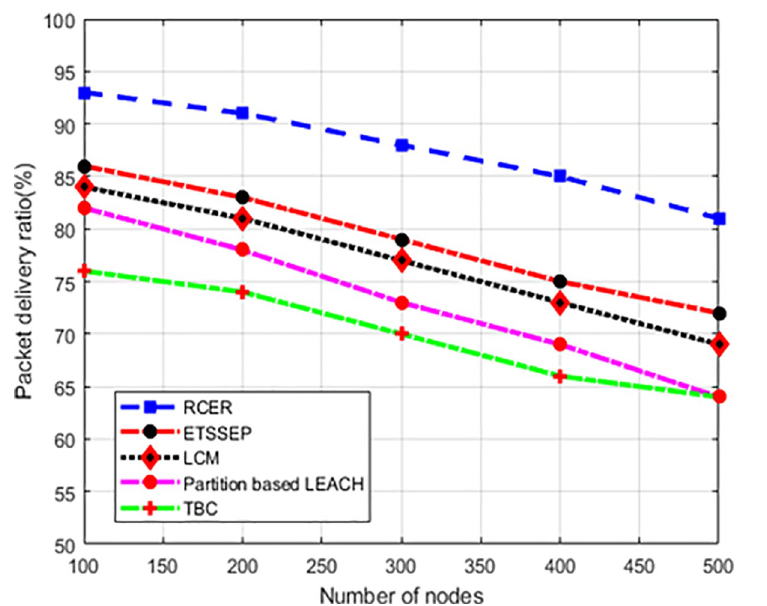
Fig 18. Packet delivery ratio in high-density